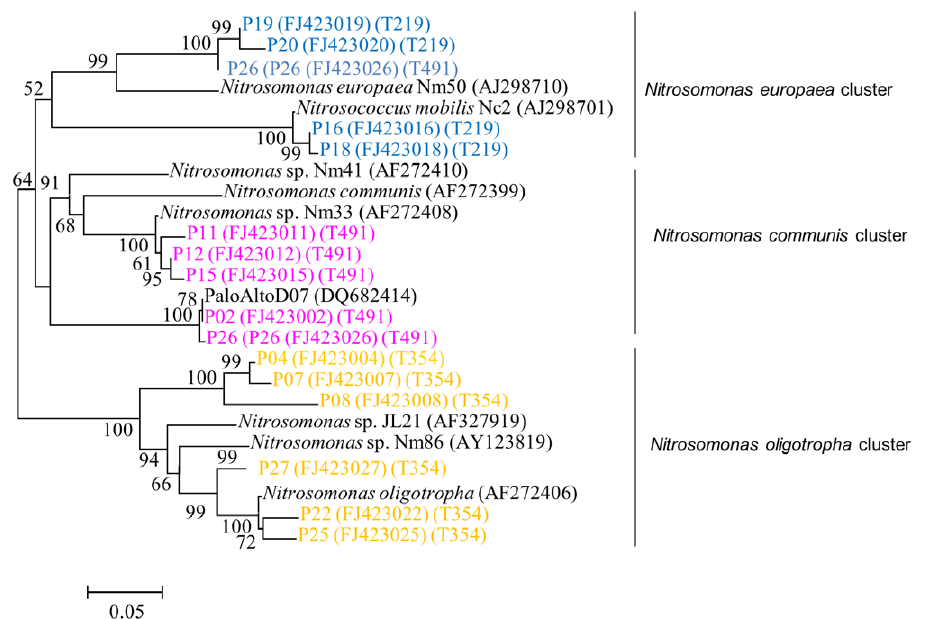
Figure 4. Phylogenetic tree showing the relationships of partial amoA gene sequences to reference sequences from the GenBank database. The tree was constructed with the neighbor-joining method using 450 nucleotide positions. Clone sequences are named beginning with ‘‘P’’, and T-RF sizes are given in parentheses beginning with ‘‘T’’.